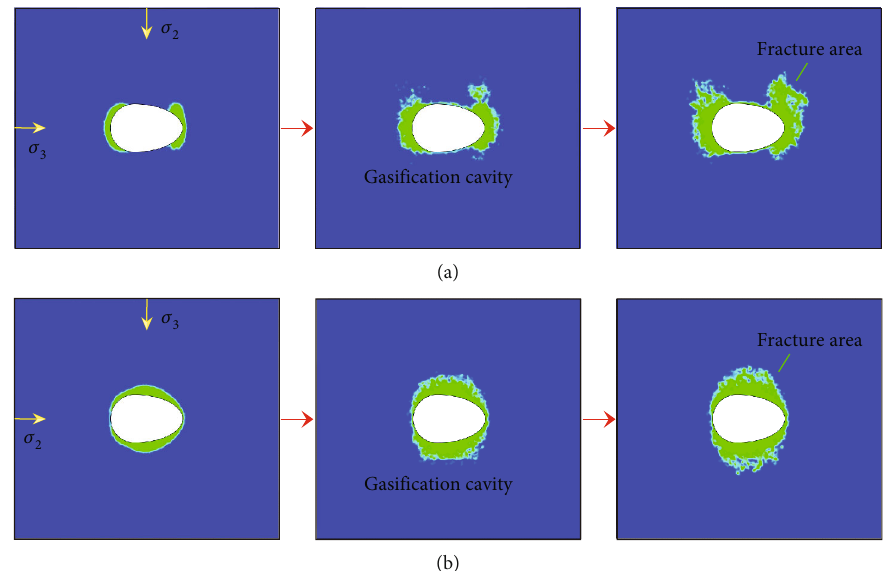
Figure 5: The in fl uence of di ff erent principal stress orientations on the rupture characteristics of the combustion cavity: (a) condition (1) and (b) condition (2).